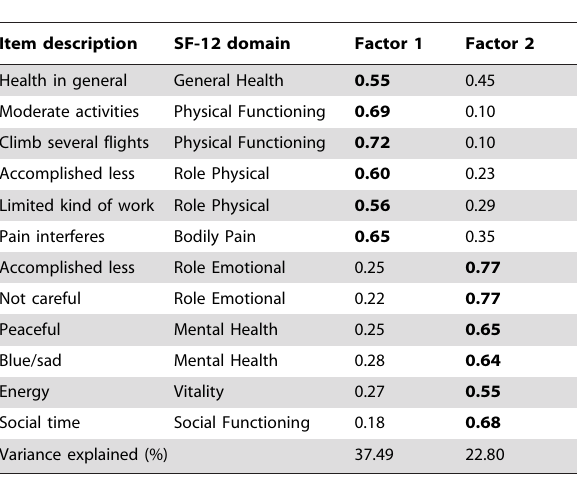
Table 5. Factor structure of the SF-12 derived from principal component